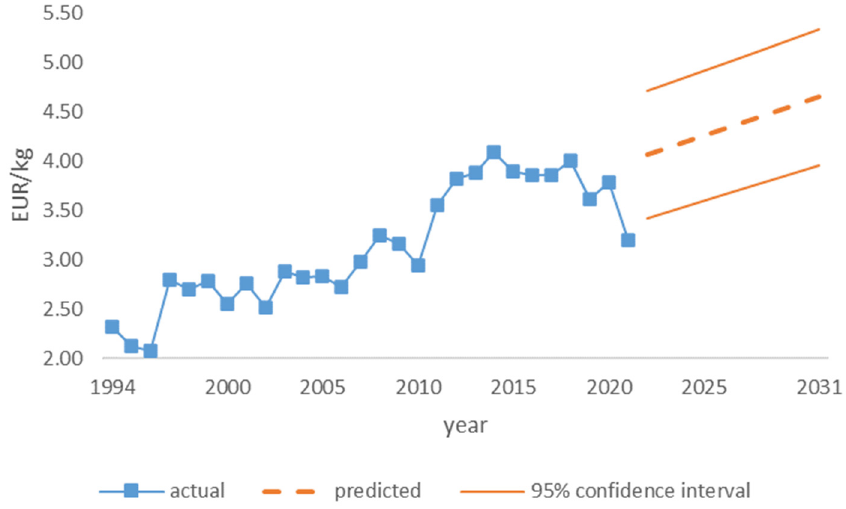
Figure 4. Real price of wild mushrooms (base = 1994) with prediction. Table 4. Real price of wild mushrooms against